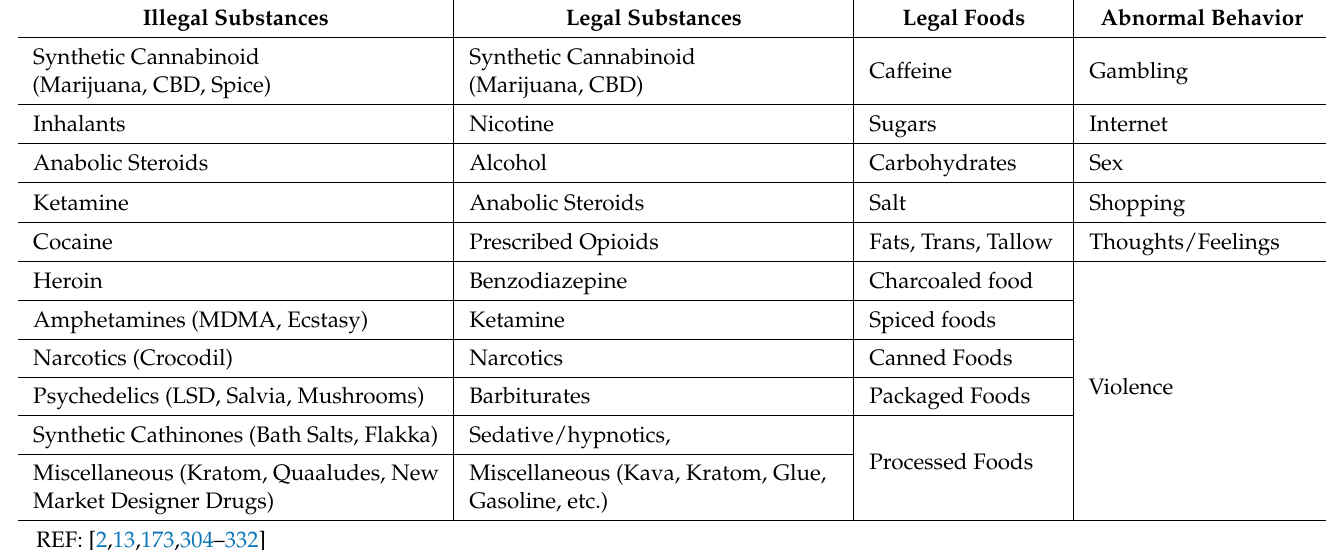
Table 8. The gateway of potential addictive substances and behaviors.